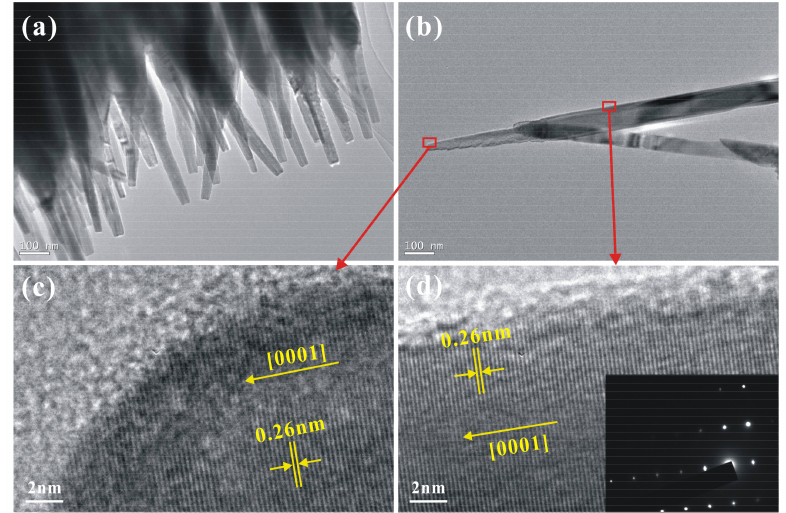
Figure 4. ( a , b ) The TEM images of the syringe-shaped ZNAs of the sample H-4. ( c , d ) HRTEM images of the selected areas marked on the syringe-shaped ZnO nanorod shown in ( b ). Inset of ( d ) is the corresponding SAED